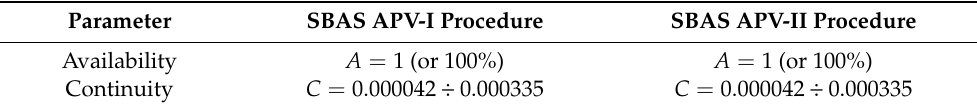
Table 2. The values of the availability and continuity terms in the air test in